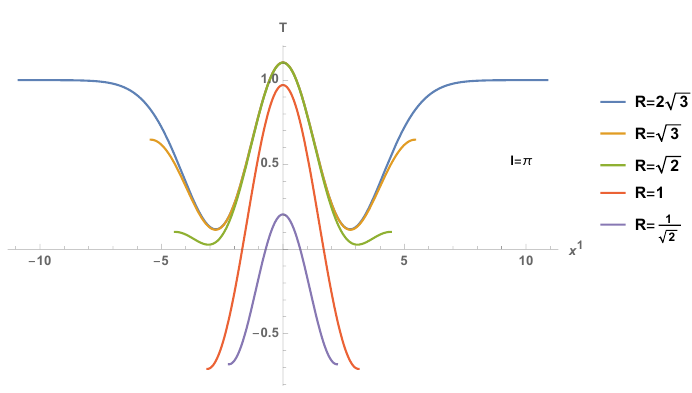
Figure 20 . Tachyon lump pro(cid:12)les in the toy model derived from excited Neumann-Dirichlet twist (cid:12)elds of weight 9 = 16, for various radii. The pro(cid:12)le is somewhat counterintuitive as we decrease the radius, as it is closest to the tachyon vacuum at x 1 = 0, precisely where the D-brane is located. For su(cid:14)ciently small radius, the lump (cid:13)attens out and its expectation value turns negative, similarly to the lump of the unexcited twist